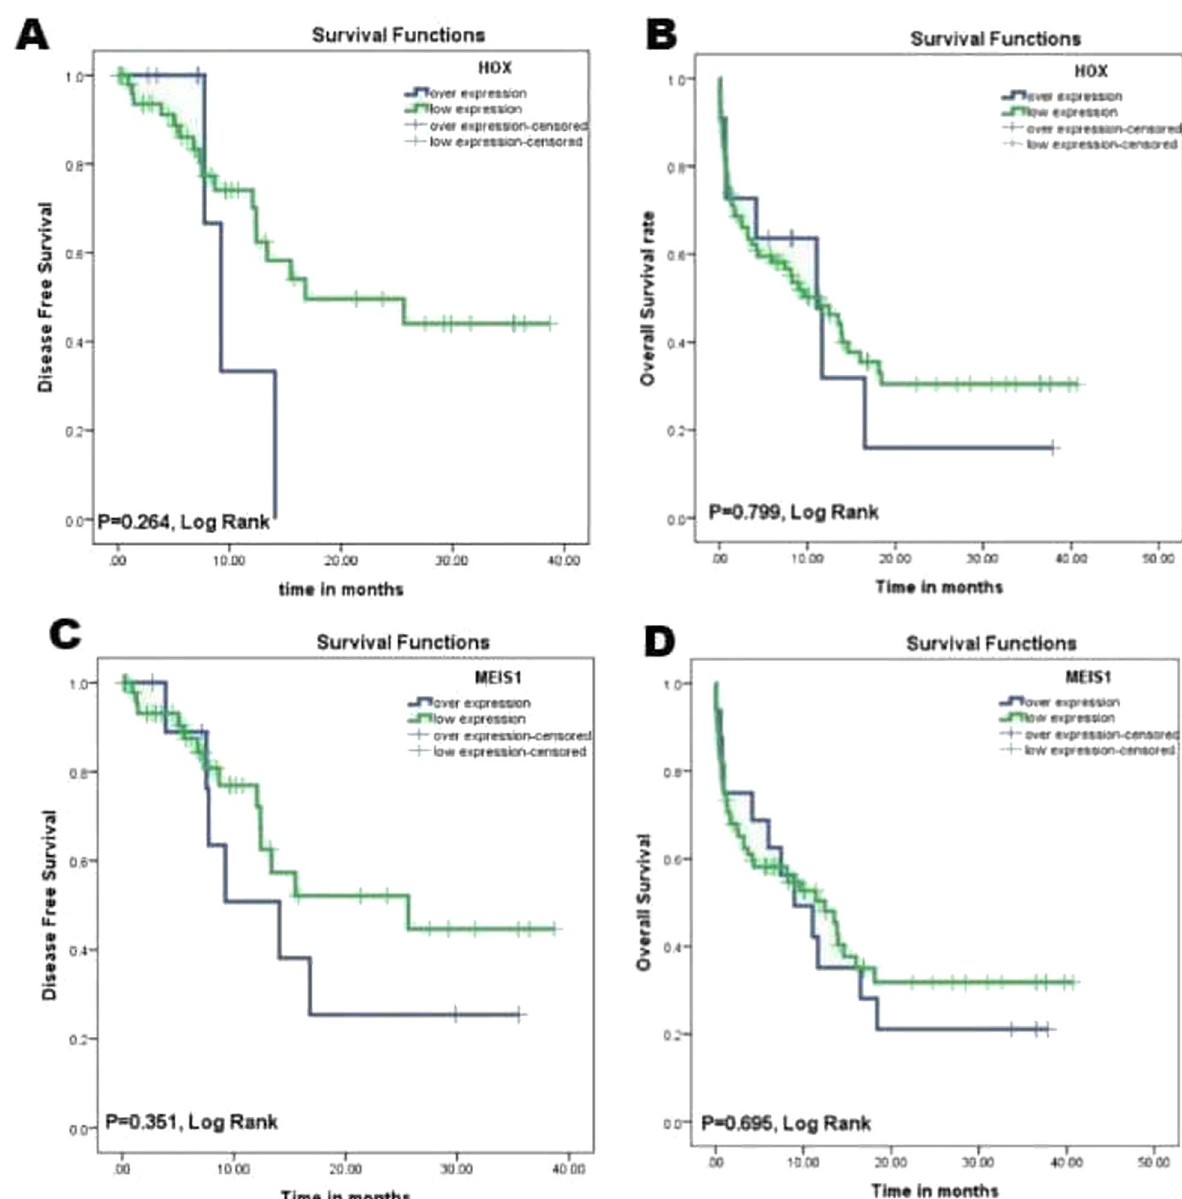
Fig. 5 Impact of HOXA9 gene expression on A DFS and B OS. Impact of MEIS1 gene expression on C DFS and D